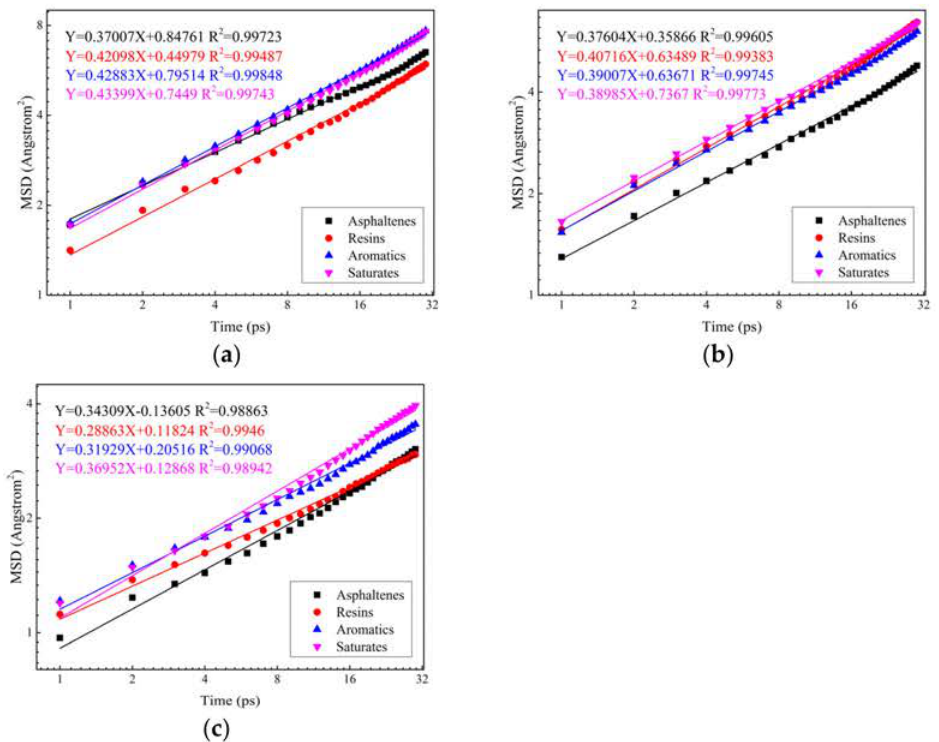
Figure 11. MSD results for virgin asphalt ( a ), RPE-modified asphalt ( b ) and CNT/RPE-modified asphalt ( c ).